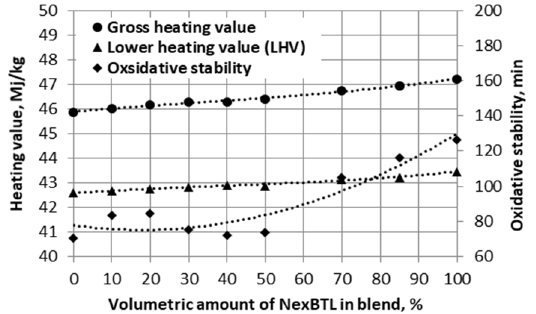
Figure 5. Dependence of the heating value (gross and lower) and improved oxidative stability on the percentage of NexBTL in fuel blends.